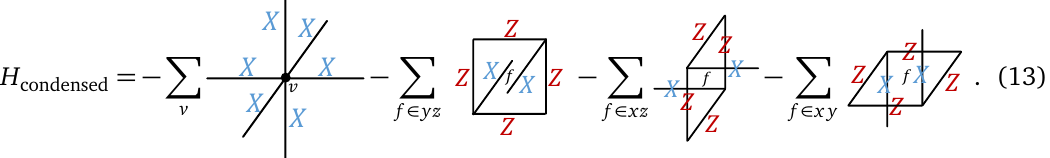
Figure 22: We prepare layers of 2d toric codes, and we put the e ↔ m twist string in one of them. On the inter-layer edges, ancilla qubits are in X Focusing on the ground state, we impose Eqs. (11) and (12) energetically